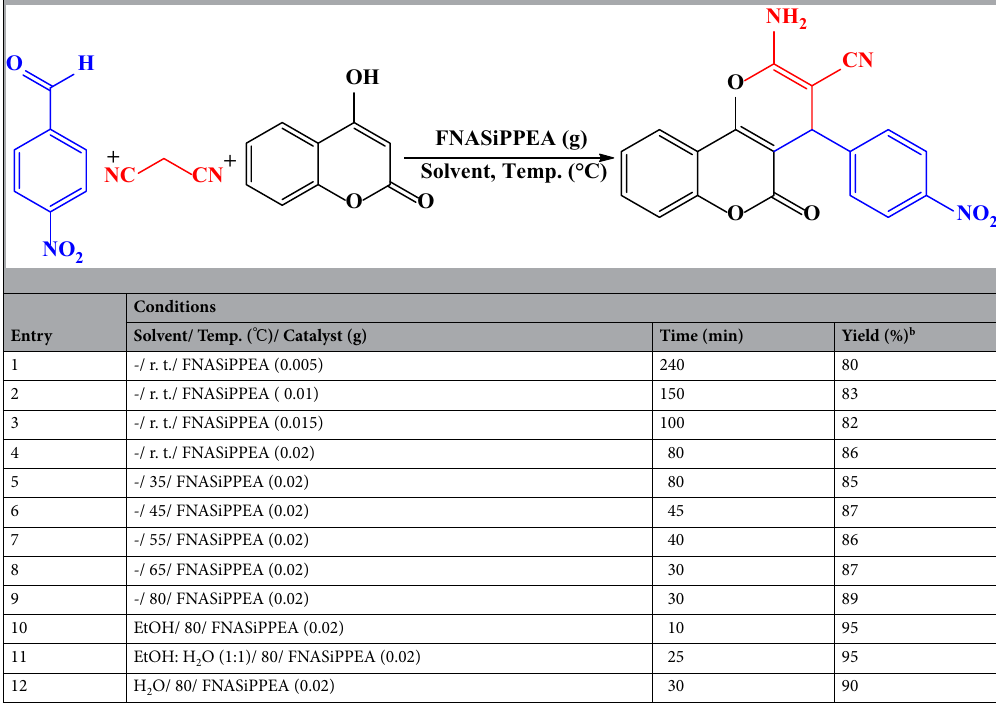
Table 2. Optimization of reaction conditions for the synthesis of DHPC. a a Conditions: 4-nitrobenzaldehyde (1 mmol), 4-hydroxycoumarin (1 mmol), and malononitrile (1.5 mmol), Solvent (10 ml). b Isolated